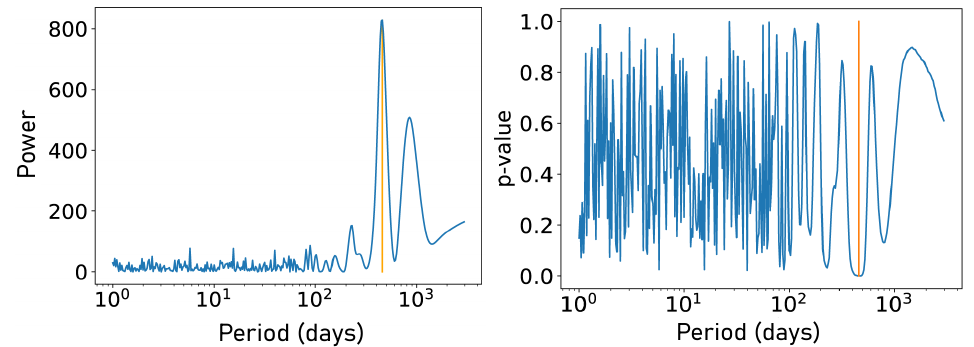
Figure 4. The left panel is the periodogram attained from the Fourier transformation of the residuals. The residuals are depicted in the right panel of Figure 3. A 457 days cycle is found. The right panel depicts the p -value of the left panel. The orange vertical lines in both panels mark the location of the cycle. KIC 9017220 is taken as an